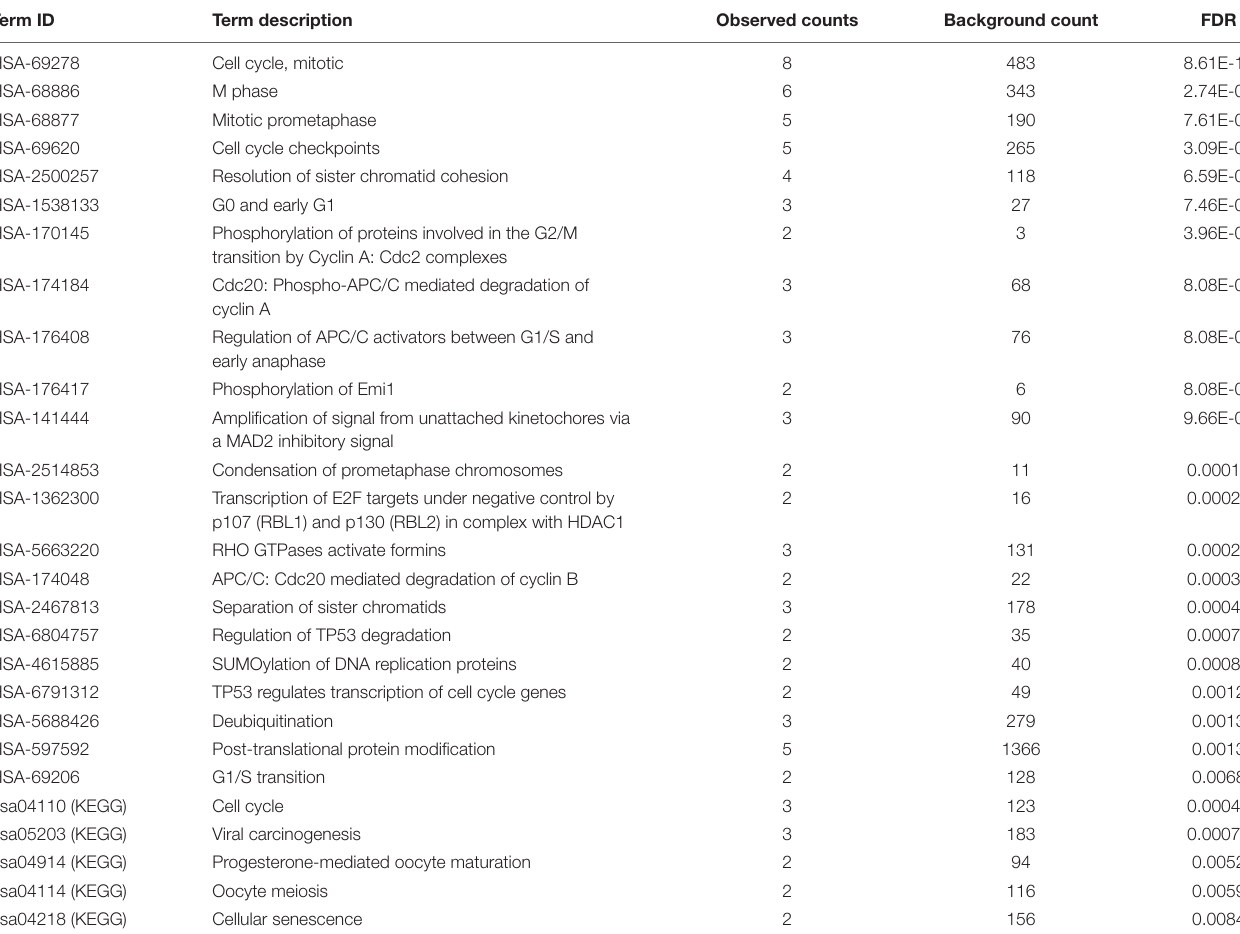
TABLE 2 | Reactome and KEGG pathway enrichment